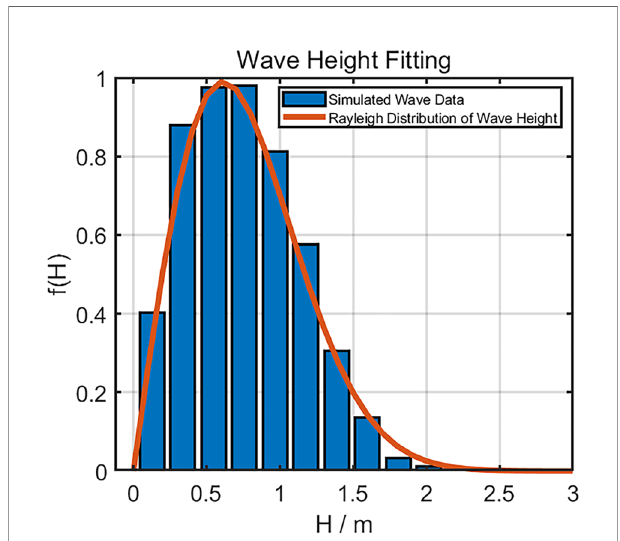
FIGURE 8 | Comparison between the probability distribution of simulated wave height and the theoretical Rayleigh distribution of wave